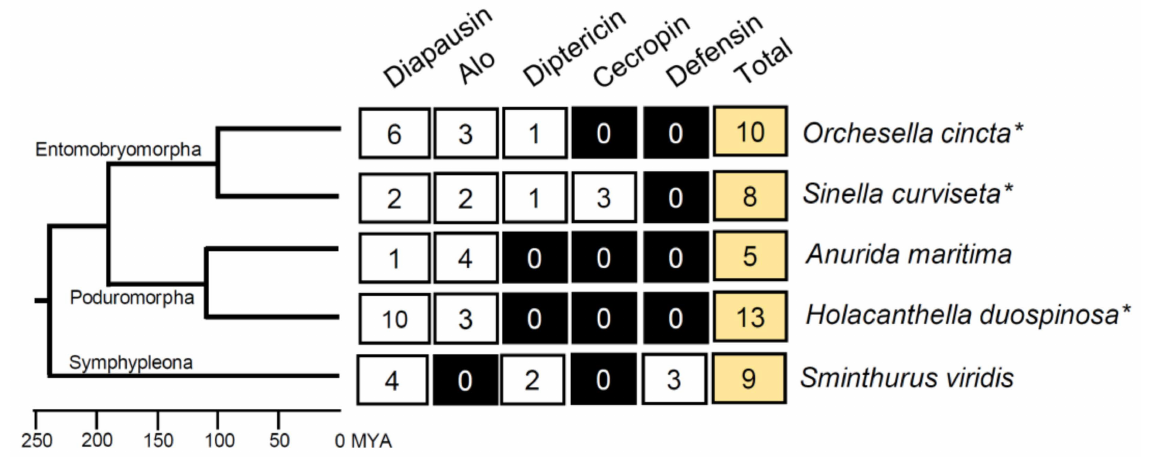
Figure 2. Collembola AMP gene families and the number of genes. Five collembola AMP gene families (diapausin, Alo, diptericin, cecropin, and defensin) are reported in this study. Phylogenetic relationships of five collembola species and the divergent time are inferred from TimeTree.org (Date access: 15 July 2022). Species with genome data are indicated with an